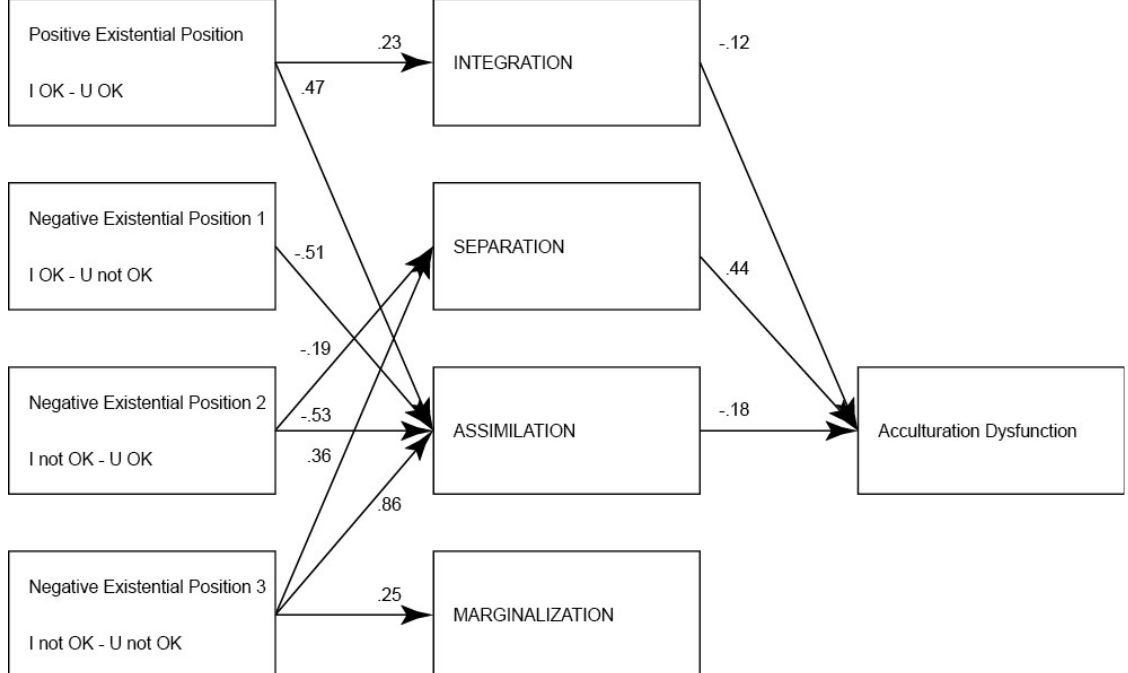
Figure 7: Relationships among the Four Existential Positions and Four Styles of Acculturation and with the Acculturation Dysfunction (with standardized coefficients for the Immigrants’ Total Sample, N =